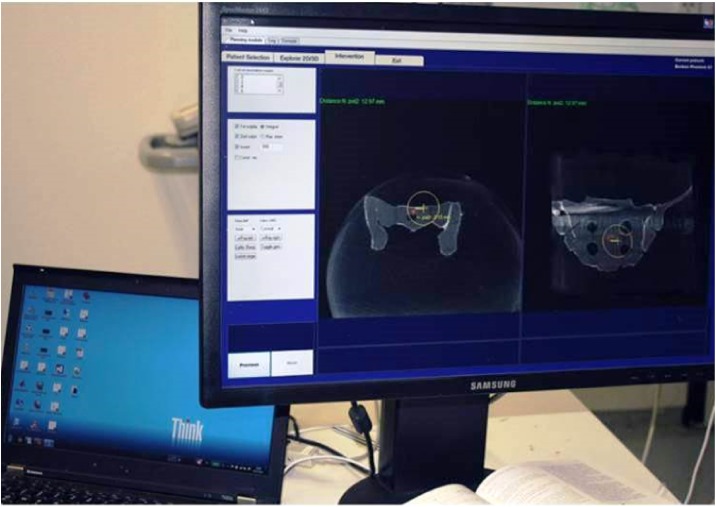
EM navigation.Illustration of the EM navigation software during k-wire positioning.